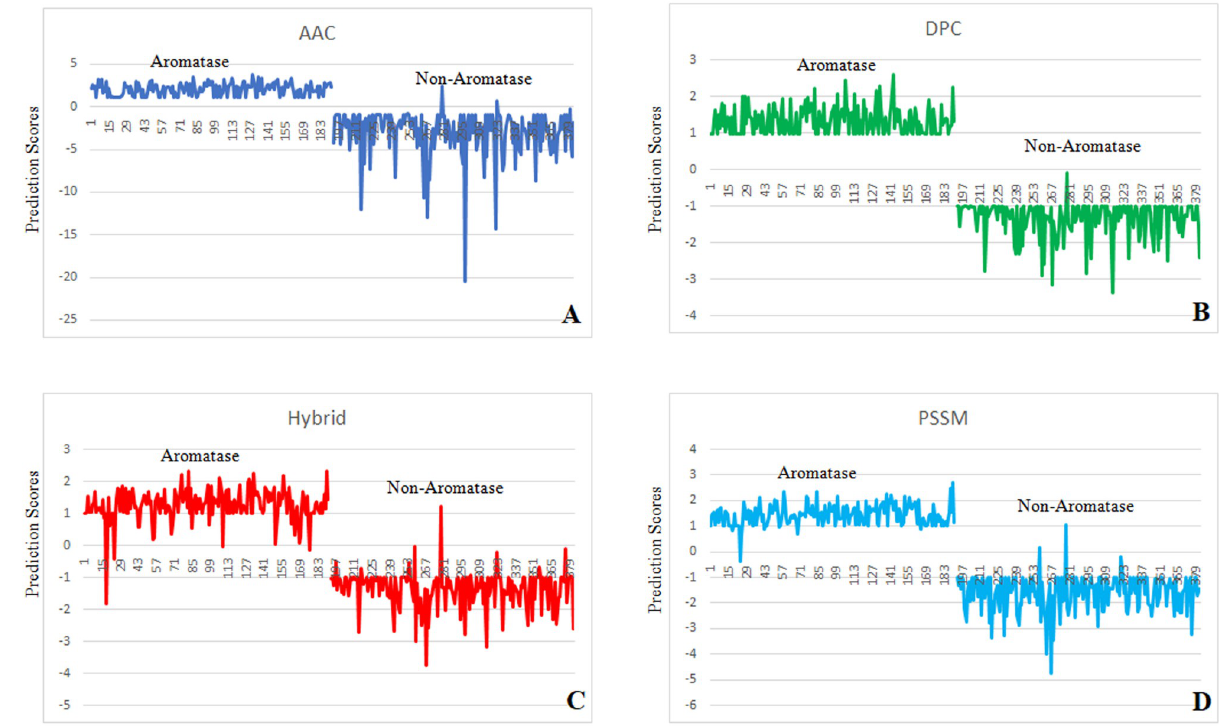
Fig 4. Prediction scores graphs: Prediction performance of the developed models on aromatase and non-aromatase proteins. A) Amino acid composition based approach (AAC), B) Dipeptide composition based approach (DPC), C) Hybrid profile based approach (AAC+DPC) and D) PSSM profile based approach.